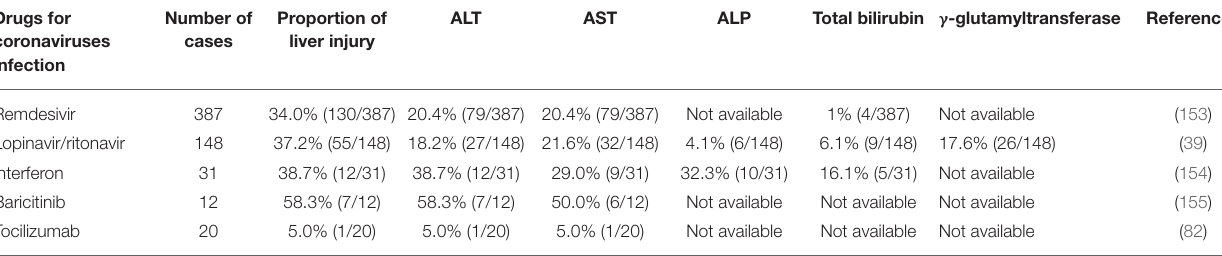
TABLE 3 | Drug-induced abnormal liver function in patients with coronaviruses infection. Drugs for coronaviruses